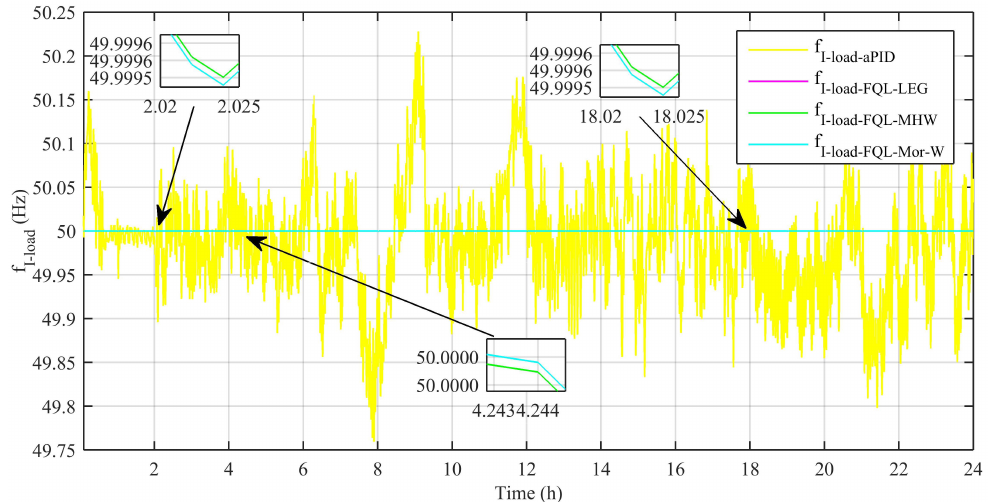
Figure 14. AC bus frequency evolution.